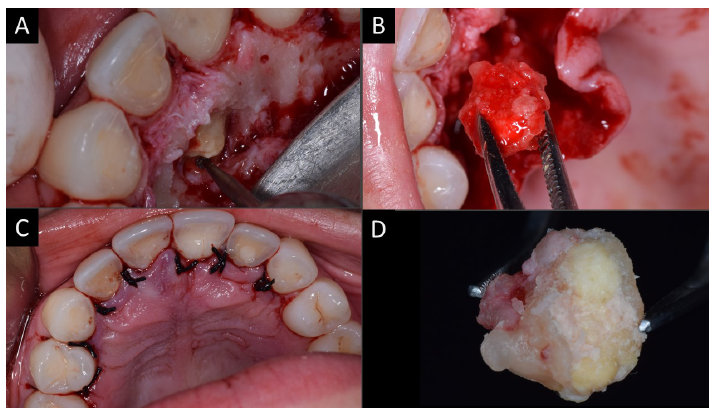
Figure 2. Surgical approach for total excision of the complex odontoma. A ) Osteotomy; B ) total excision of the odontoma; C ) repositioning of flap and intra-sulcular suture; D ) enucleated complex